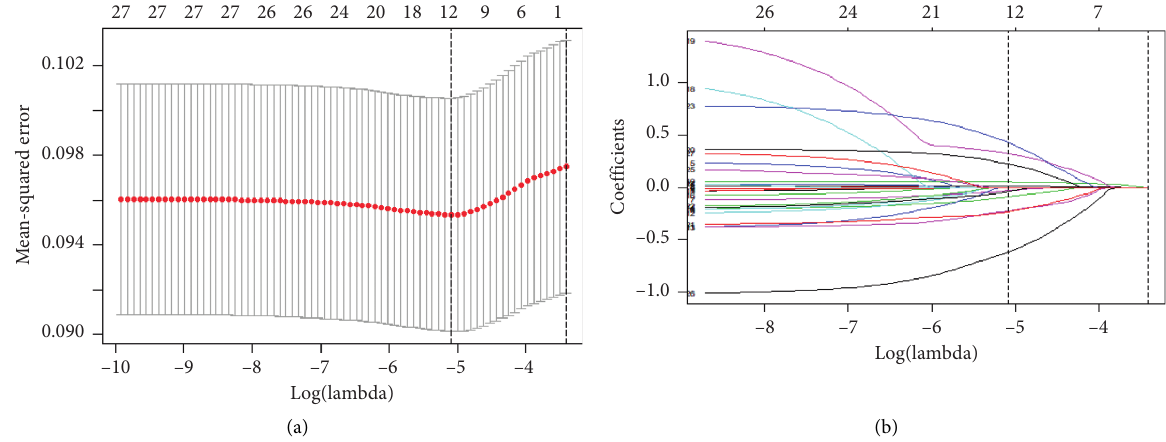
Figure 3: Variable selection using the LASSO binary regression model. Notes: (a) optimal parameter (lambda) selection in the LASSO model used tenfold cross-validation via minimum criteria. The partial likelihood deviance (binomial deviance) curve was plotted versus log(lambda). Dotted vertical lines were drawn at the optimal values by using the minimum criteria and the 1-SE of the minimum criteria (the 1-SE criteria). (b) LASSO coefficient profiles of the 27 features. A coefficient profile plot was produced against the log(lambda) sequence. Vertical line was drawn at the value selected using tenfold cross-validation, where optimal lambda resulted in 12 features with nonzero coefficients. Abbreviations: LASSO, least absolute shrinkage and selection operator; SE, standard